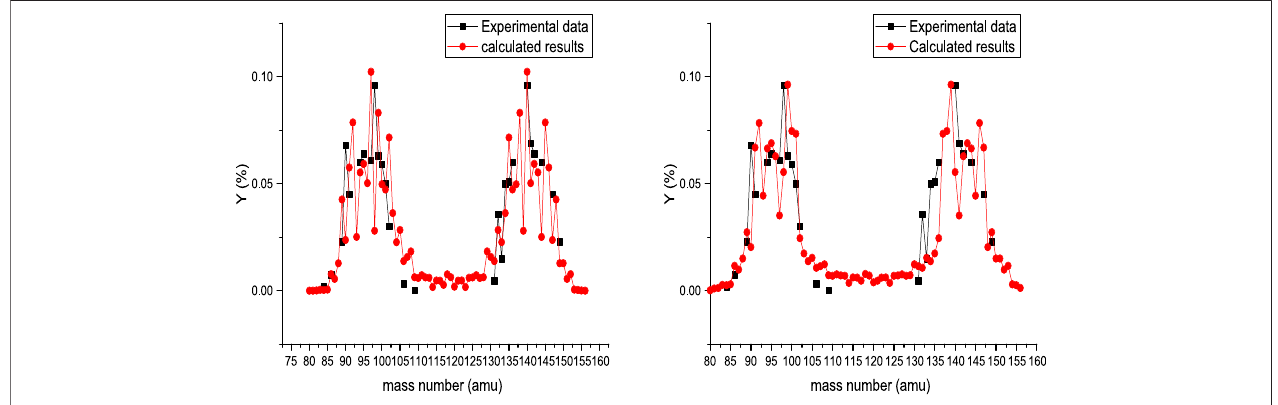
FIGURE 1 | Calculated mass yield for spontaneous fi ssion of 238 U accompanied by experimental data [35]. In the left and right sides are presented the calculated results obtained for T coll (cid:1) 1 MeV and T coll (cid:1) 2 MeV,